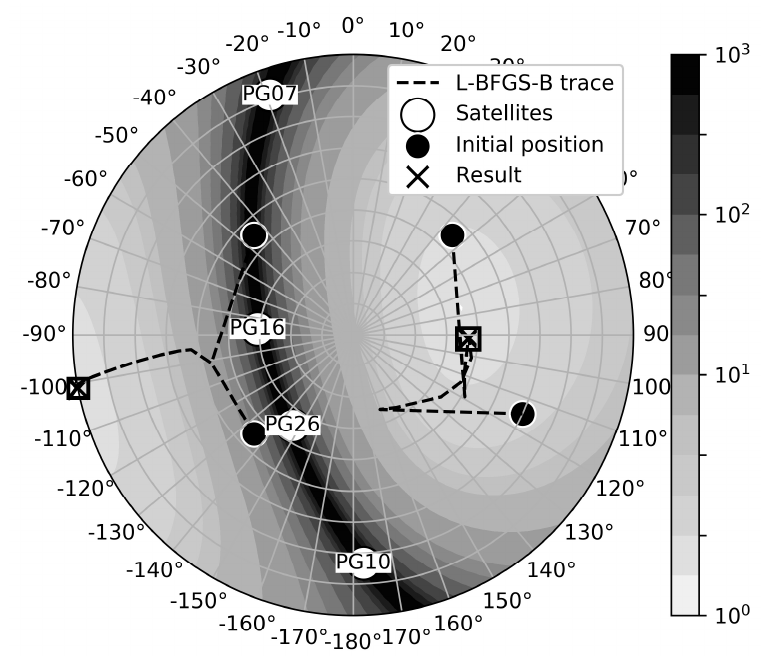
Figure 5. The L-BFGS-B algorithm traces for four initial positions of the transceiver. Results show two optimal locations, one on the east side and one on the west side of the sky depending on initial position.